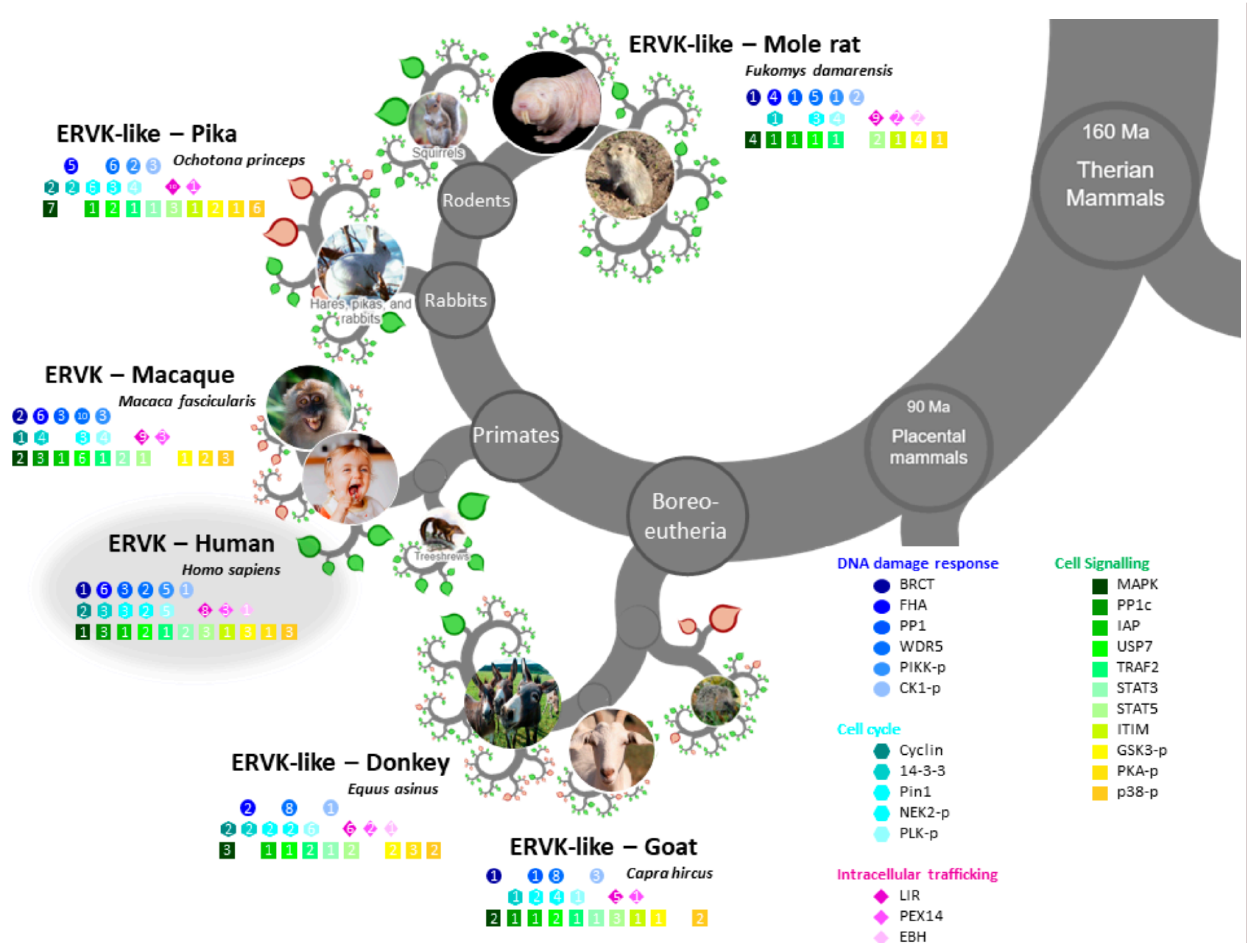
Figure 2. ERVK integrase and similar endogenous integrases share eukaryotic linear motifs patterns. Modified OneZoom image illustrating the conservation of ELM motifs in integrases from eukaryotic organisms ( Homo sapiens, Macaca fasicicularis, Fukomys damarensis, Ochotona princeps, Equis asinus, and Capra hircus ). Motifs are color-grouped according to function; DDR (blue), cell cycle (cyan), cell signaling (green), and intracellular trafficking (magenta). The number in each colored shape refers to the number of motifs with the respective integrase